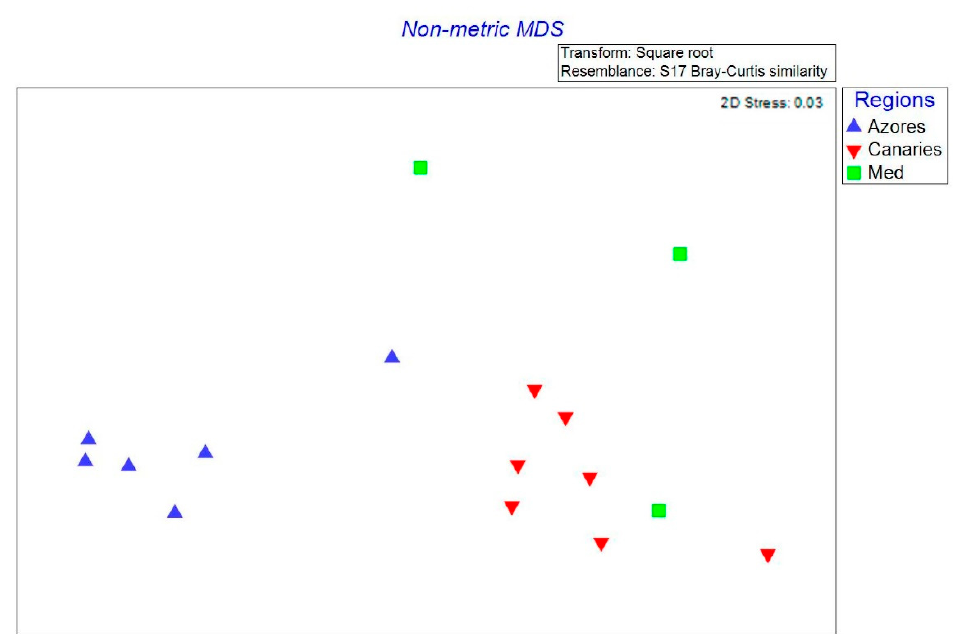
Figure 7. Non-mMDS, based on Bray–Curtis similarity of square root transformed data of the Cd content among algae, invertebrates, and fishes compared between regions (Azores, Canaries, and Mediterranean). Tests for differences between unordered regions groups (ANOSIM): Global Test Sample statistic I: 0.789; Significance level of sample statistic: 0.1%; Number of permutations: 999.